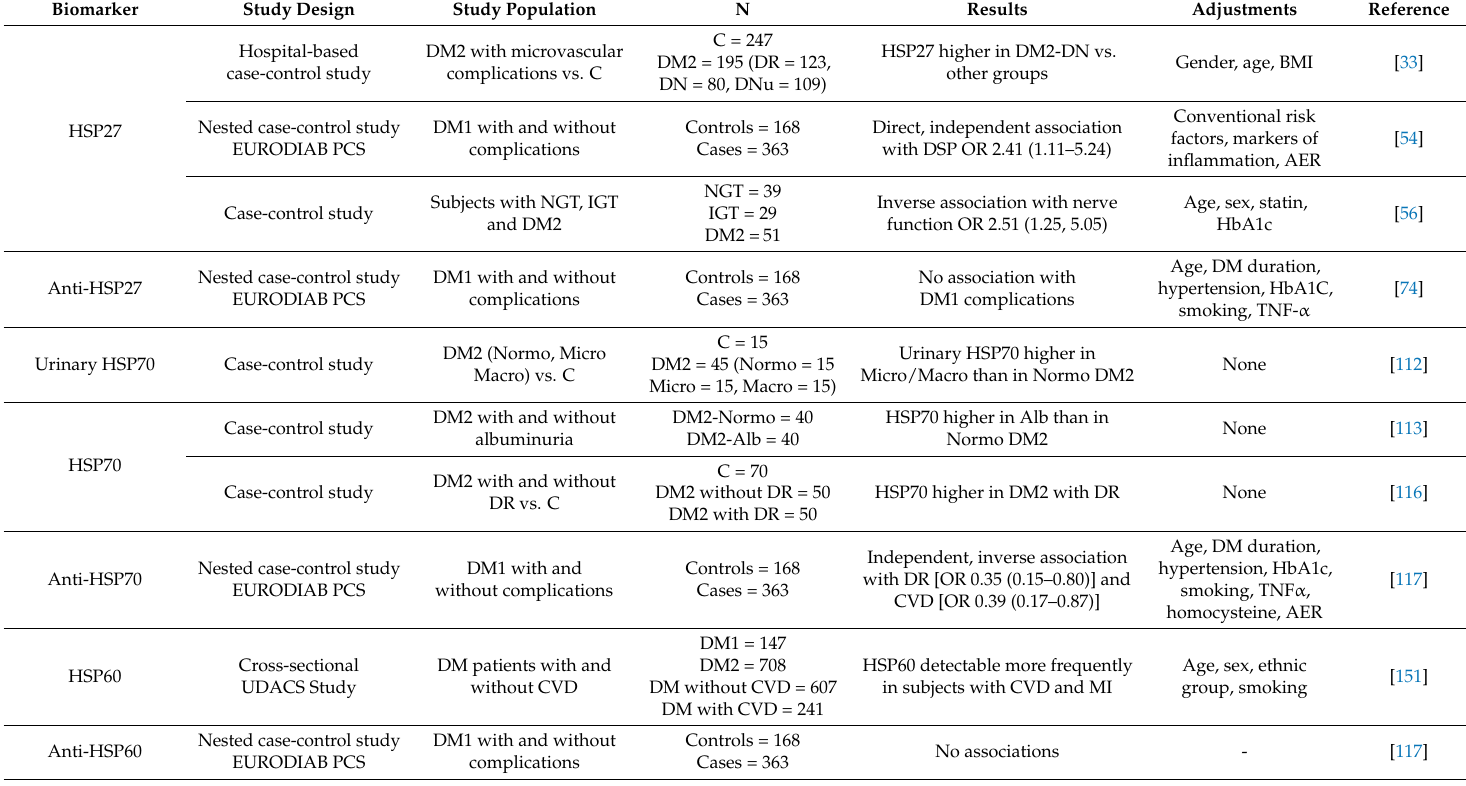
Table 3. Summary of Clinical Studies on Circulating HSP and anti-HSP Levels in Patients with Diabetic